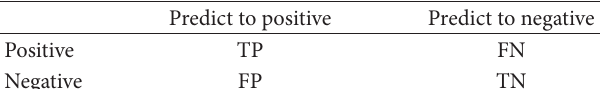
Table 2: Confusion matrix.